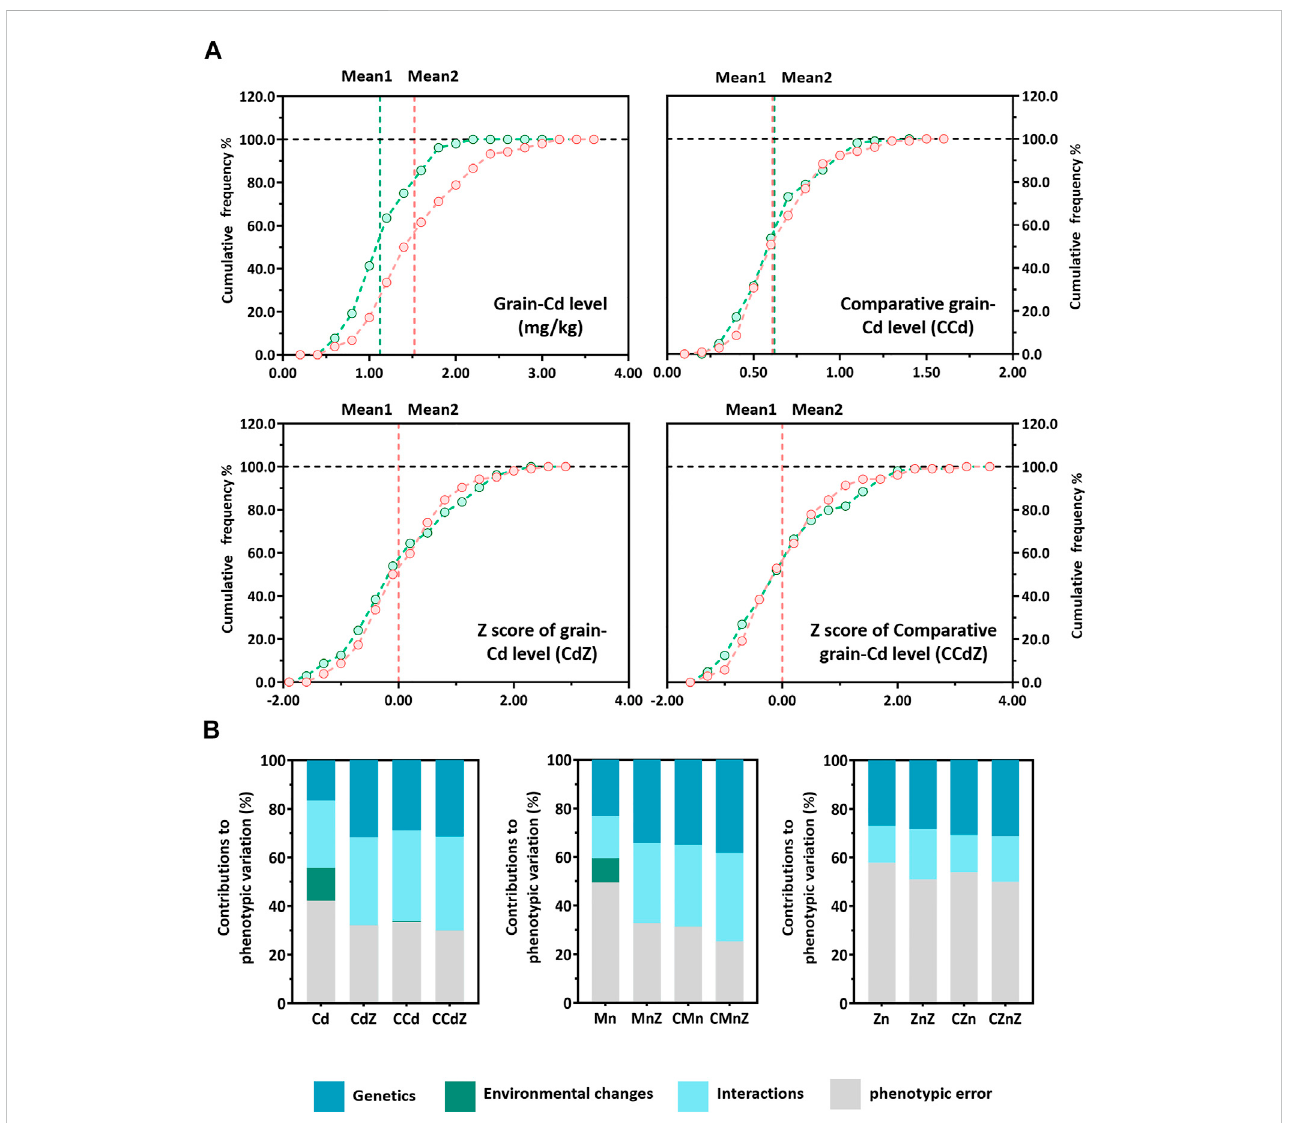
Performance of grain-Cd in the different normalization approaches and the different phenotypic components. (A) Performance of Cd accumulation in rice grains using different normalization approaches. (B) Contributions of different phenotypic components to the phenotypic variations in the different normalization approaches. The regions in blue, green, cyan, and gray represent the genetic contributions, environmental changes, interactions between genetic contributions and environmental changes, and the phenotypic error,